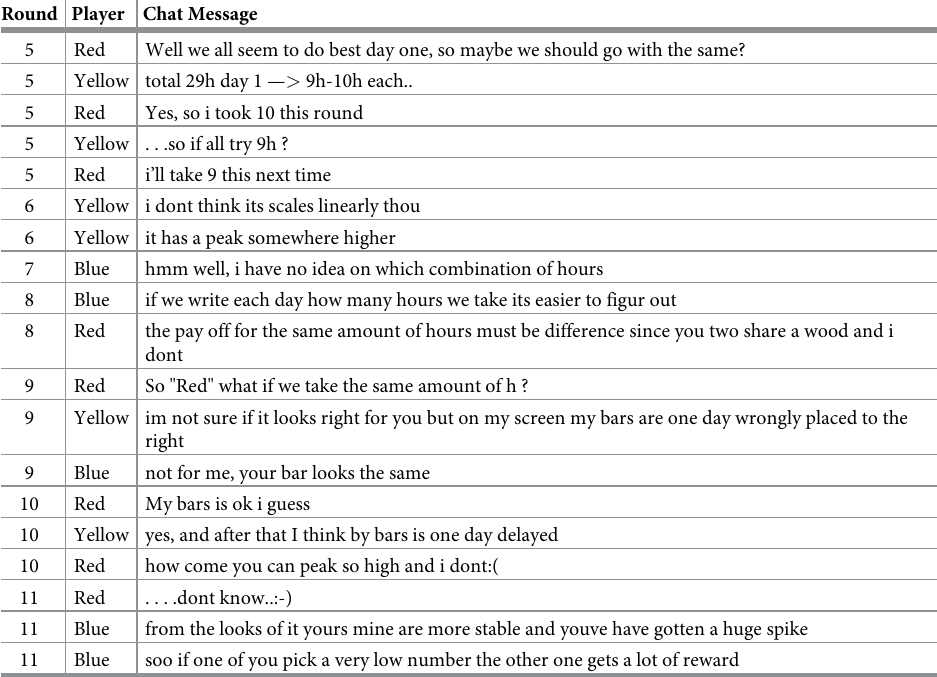
Table 8. Chat 3—Information increases cognitive load (especially after round 9). Round Player Chat